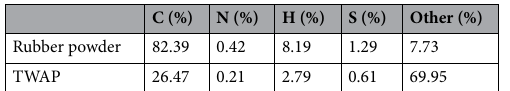
Table 3. Weight percentage of C, N, H and S in rubber powder and TWAP.